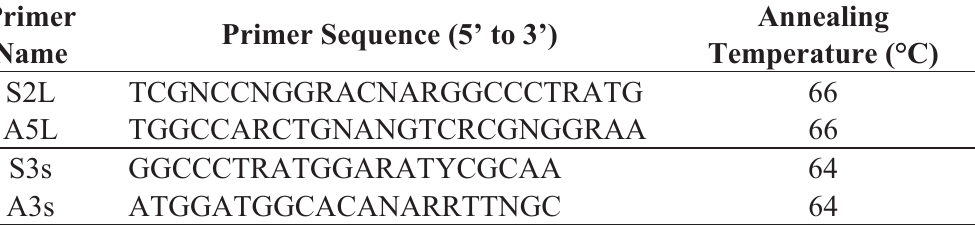
Table 1. Nested primer pairs used to amplify Tallapoosa darter CENP-A gene from within exon 2 to within exon 4.